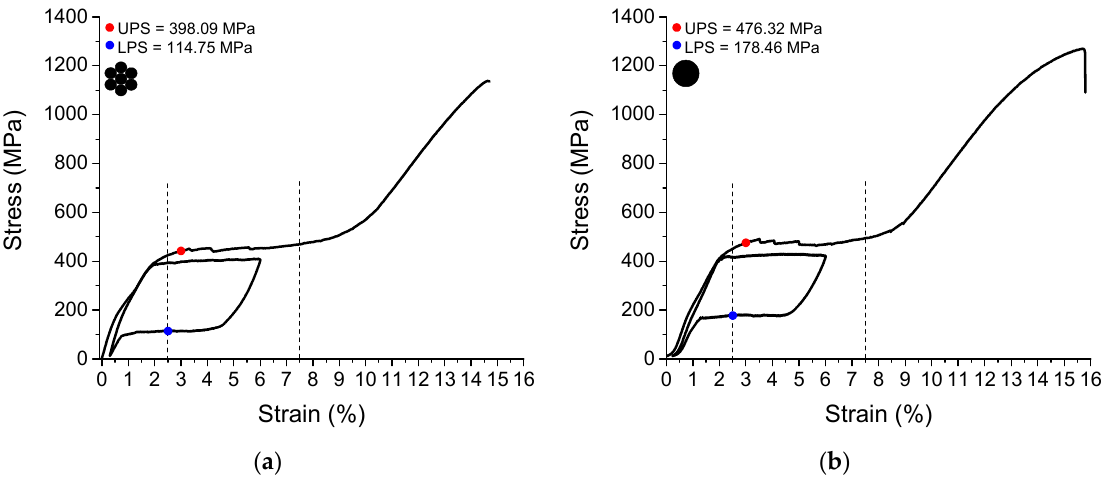
Figure 5. Quasi-static superelastic response. ( a ) NiTi SMA micro cable. ( b ) Reference element. The vertical lines indicate the oscillation amplitude selected for the cyclic tension tests.